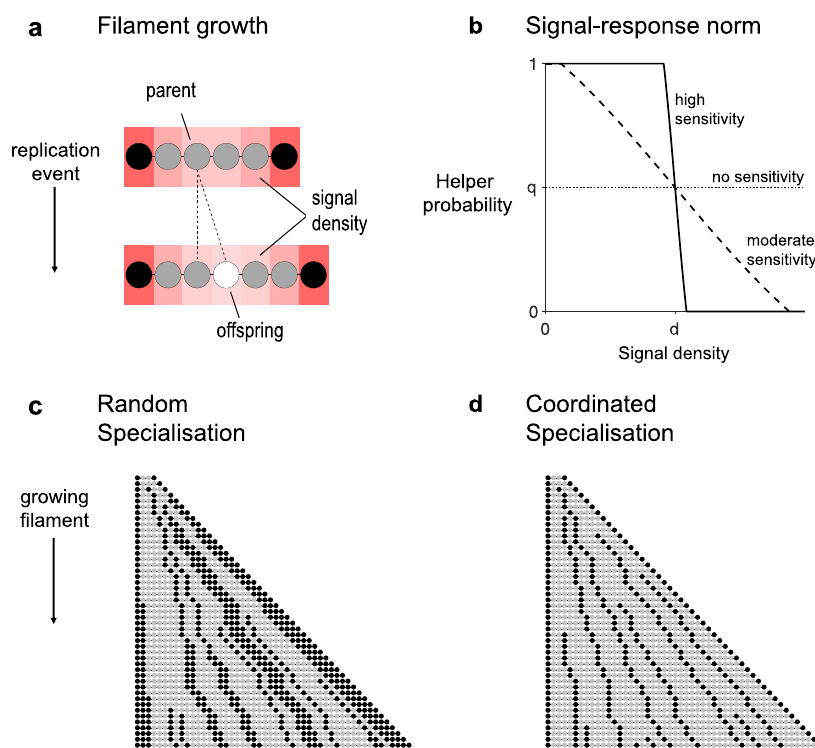
Fig. 4 Division of labour in a cyanobacteria fi lament. a Black cells represent helpers, and grey cells reproductives. When a reproductive replicates, the parent cell produces an offspring cell (white cell) to one side of itself along the fi lament. The blue shading shows the density of the signal molecule produced by the helpers as it diffuses along the fi lament. b When an offspring cell is sensitive to the signal ( v > 0), a greater (lesser) signal density will decrease (increase) the probability that it becomes a helper ( q ¼ 0 : 5 ; d ¼ 5 ; v ¼ 0 ; 0 : 2 ; 1). c A simulated example of a fi lament growing that employs random specialisation ( q ¼ 0 : 33 ; s ¼ 0, d ¼ 0, and v ¼ 0). d A simulated example of a fi lament growing that employs coordinated specialisation ( q ¼ 0 : 33 ; s ¼ 0 : 1, d = 1 and v ¼ 1 : 5) (Methods: Cyanobacteria fi laments). The helper cells (black) are more evenly spaced out (less clumped) with coordinated specialisation compared to with random